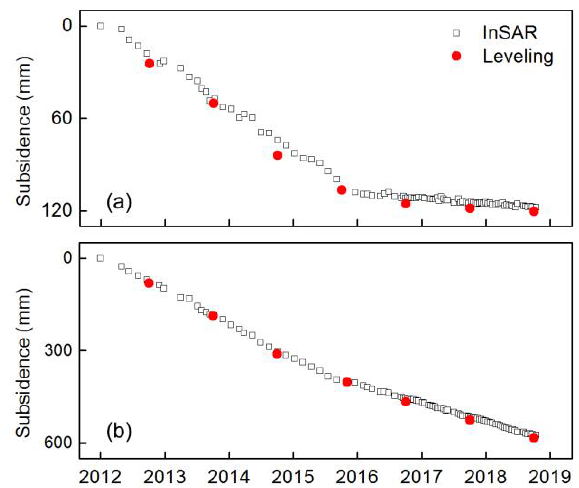
Figure 11. ( a ) and ( b ) Comparison between time series subsidence derived by InSAR and leveling results in two levelings, respectively, whose locations are shown in Figure 1 with levelings-I.